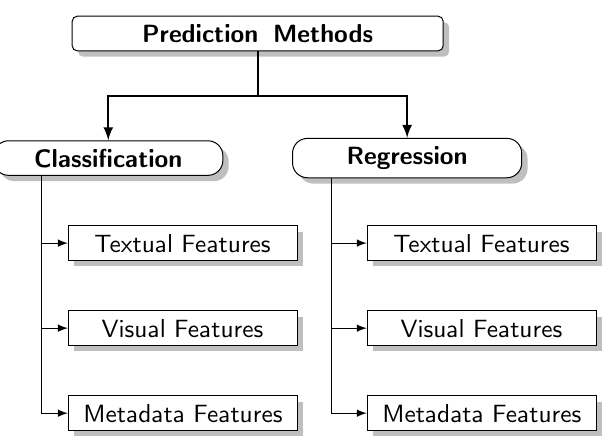
Figure 1. Taxonomy according to the prediction methods and attributes